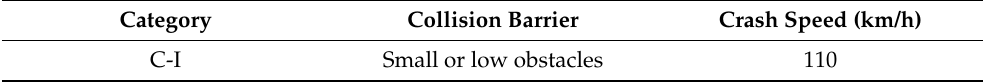
Table 8. Selected collision